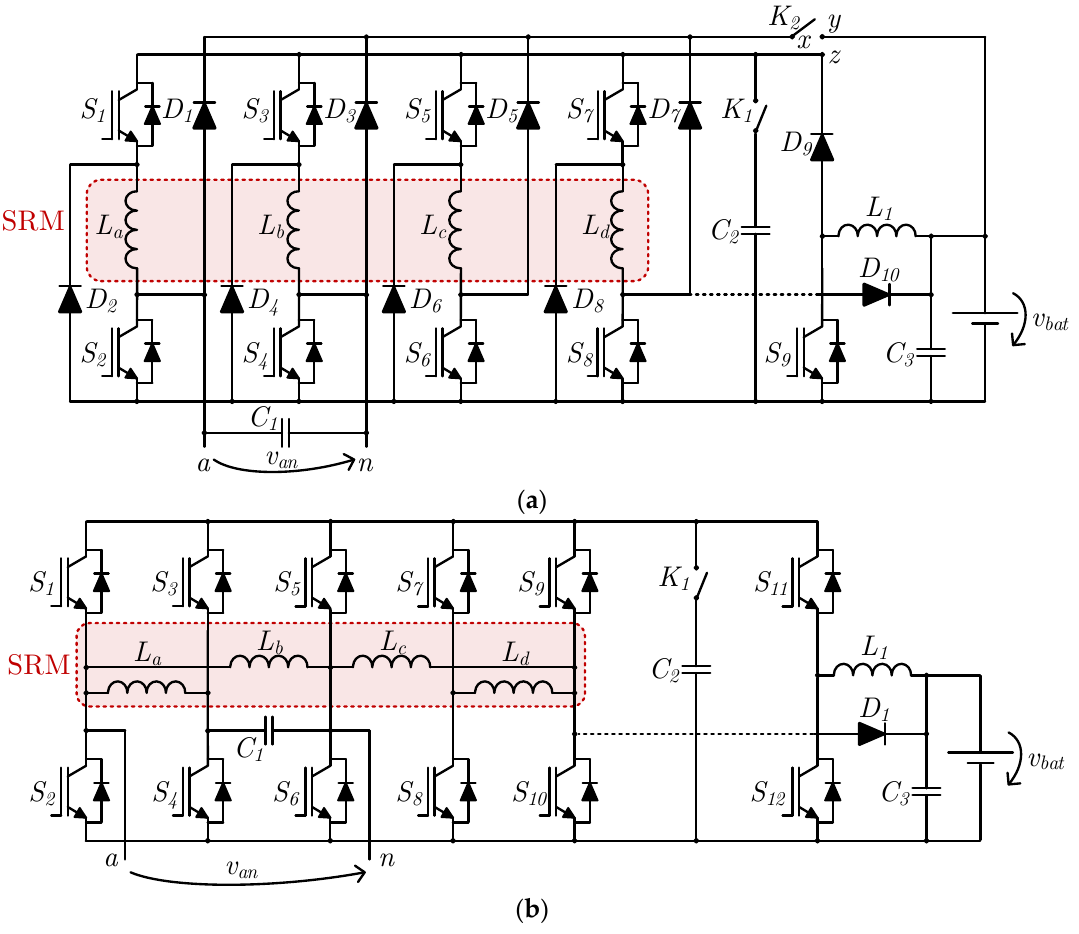
Figure 7. EV IBCs based on SRMs proposed by H. C. Chang and C. M. Liaw in: ( a ) 2009 [19]; ( b ) 2011 [20].